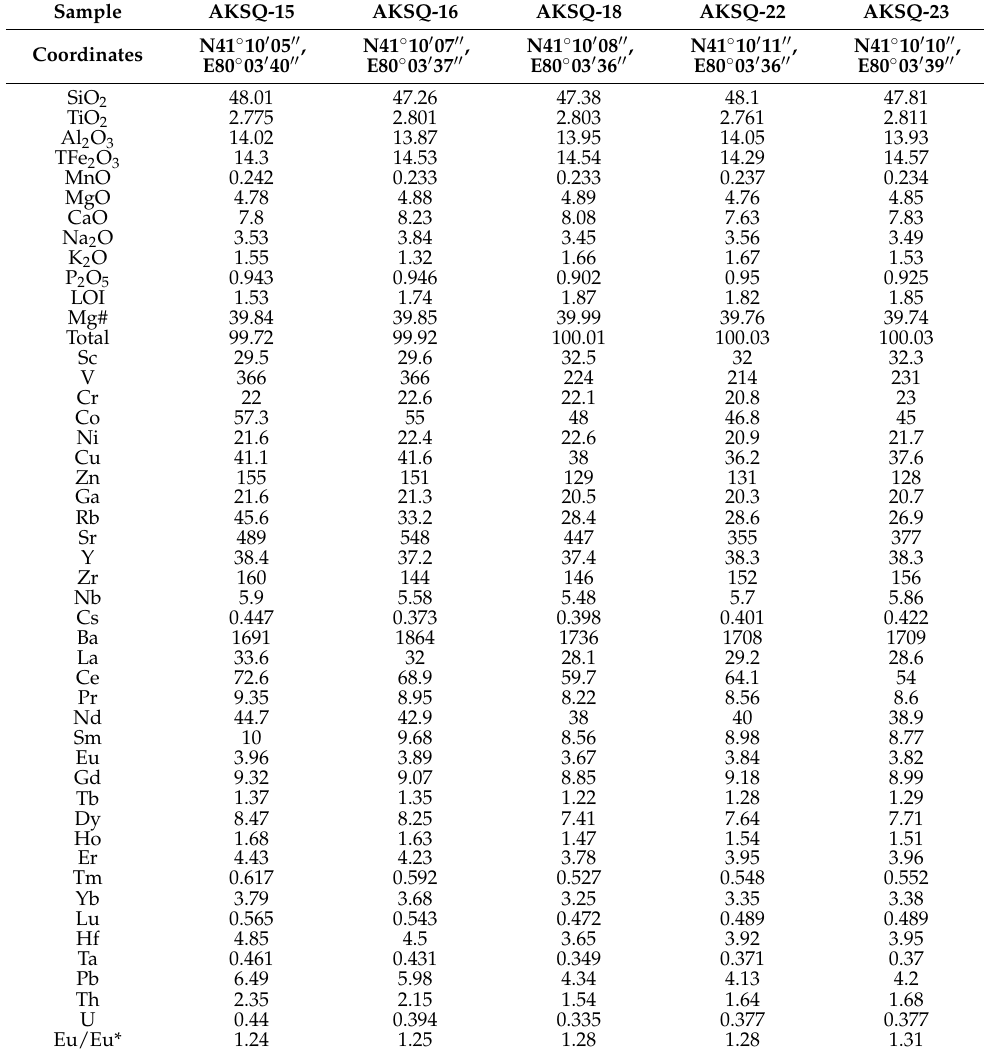
Table 1. Major oxide (wt.%) and trace element (ppm) compositions of the Aksu Neoproterozoic diabase dykes, Chinese South Tianshan. Sample AKSQ-15